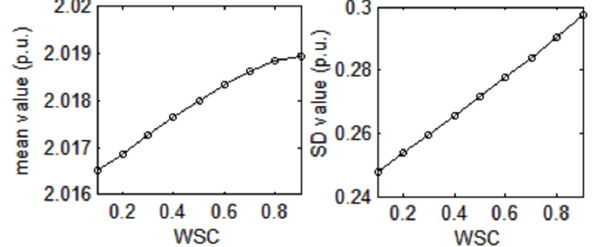
Figure 11. µ - P σ - P 1 ´ 2 , 1 ´ 2 of 3-order SG-PLF under different